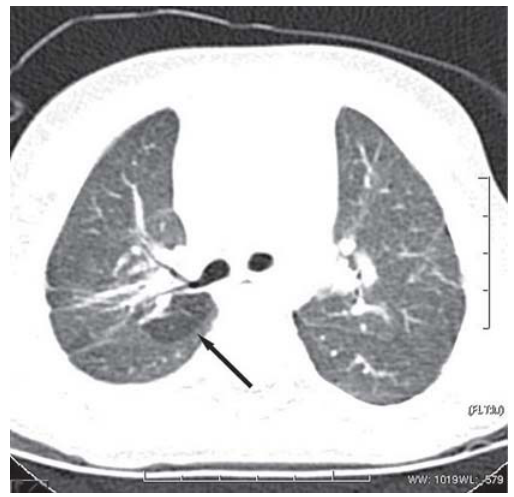
Fig. 3 - M.N.R., sexo feminino, 2 anos e 9 meses de idade e peso de nascimento de 640 gramas. Imagem obtida na altura dos brônquios principais, lesão hipoatenuante subsegmentar de contornos bem definidos, com aspecto de área de redução da atenuação e dos vasos, no segmento superior do lobo inferior direito (seta)